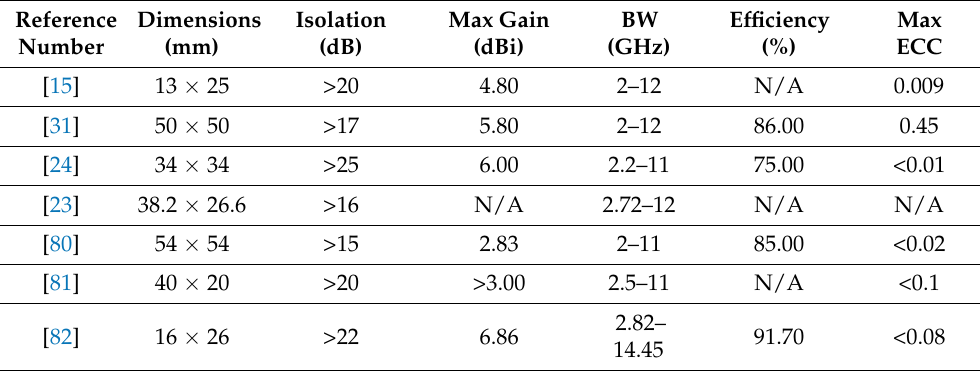
Table 8. Comparison of proposed 8-ports MIMO antenna with several reference antennas for 5G and satellite